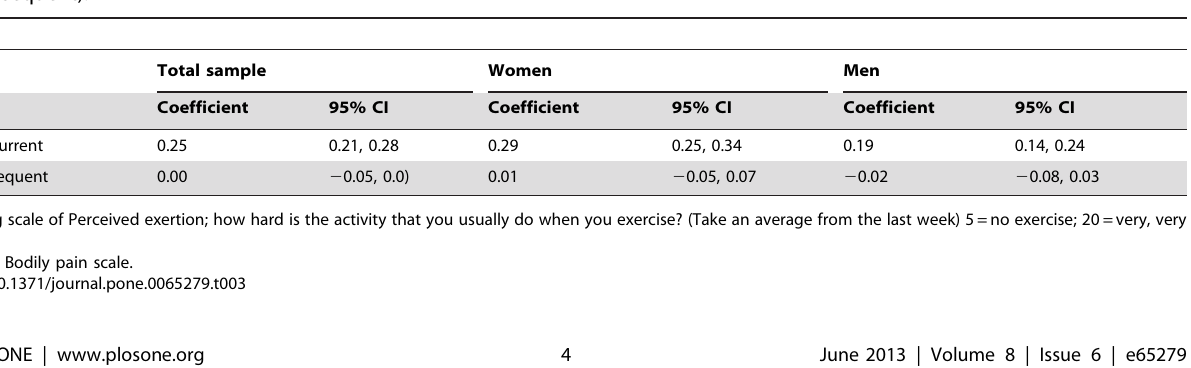
Table 3. Within subjects associations between exercise* and pain { at the same time points (concurrent) and after three months